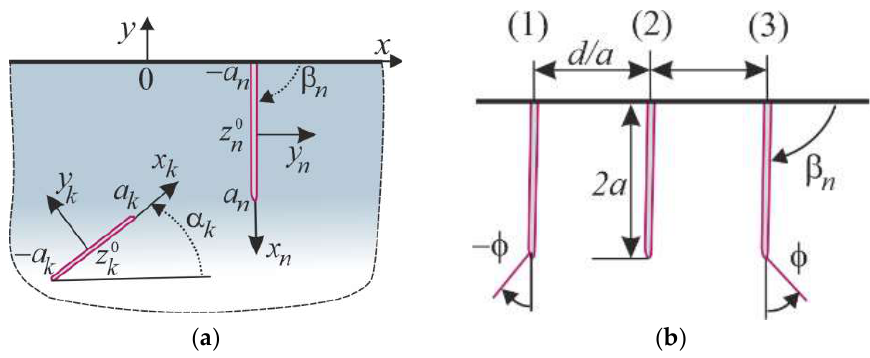
Figure 2. ( a ) Global (x, y) and local (x k , y k ) coordinate systems; ( b ) three edge cracks.